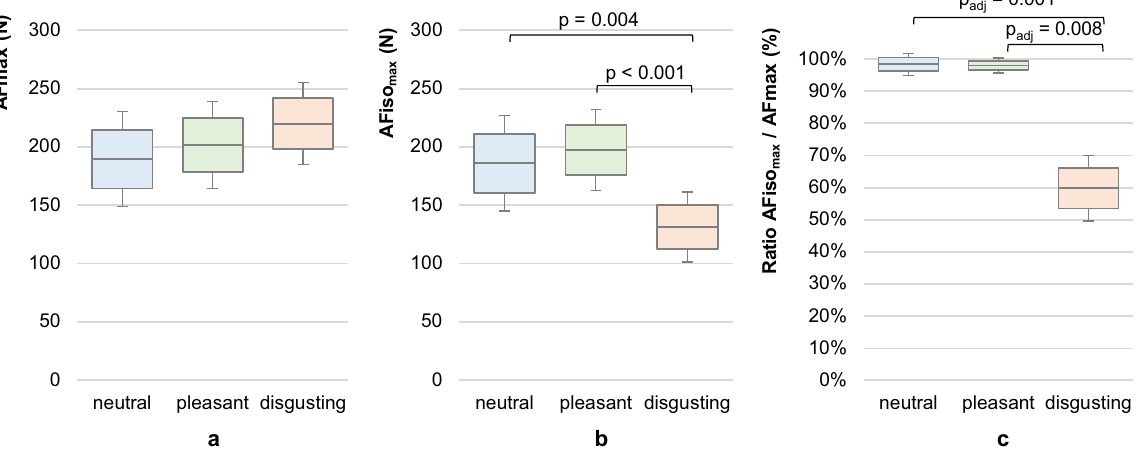
Figure 6. Maximal Adaptive Force and maximal isometric Adaptive Force. Displayed are the arithmetic means, standard deviations (error bars) and 95%-CIs of ( a ) the maximal Adaptive Force (AFmax), ( b ) the maximal isometric Adaptive Force (AFiso max ) and ( c ) the ratio of AFiso max to AFmax comparing the odours neutral (blue), pleasant (green) and disgusting (orange). The p-values of significant comparisons are